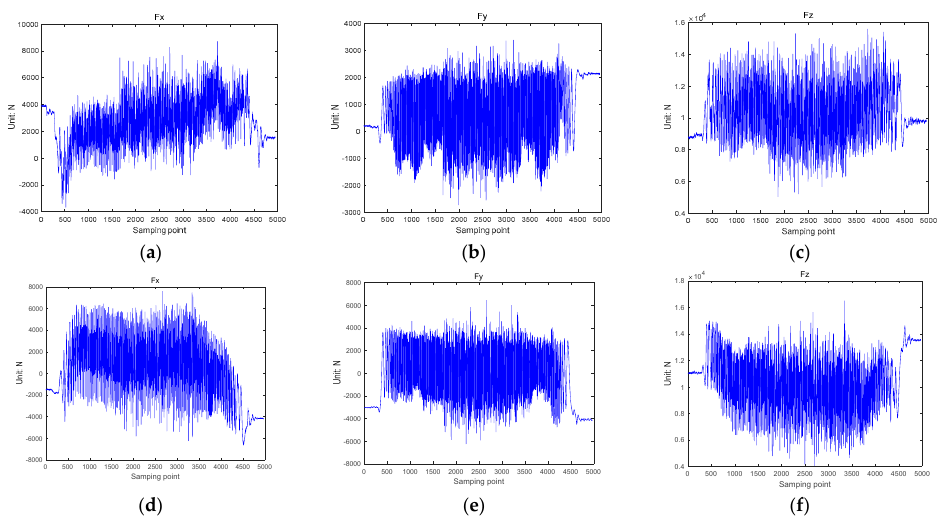
Figure 5. The original loads on the standard road, ( a ) F x of the left WFS, ( b ) F y of the left WFS, ( c ) F z of the left WFS, ( d ) F x of the right WFS, ( e ) F y of the right WFS, ( f ) F z of the right WFS. The original loads collected by the WFS on the target road are shown in Figure 6. Similar to Figure 5, Figure 6a–c represents the three ‐ dimensional loads F x , F y , and F z of the left WFS, and Figure 6d–f represents the three ‐ dimensional loads F x , F y , and F z of the right WFS. The target cobblestone road is also 200 m long. Similar to the standard road, approximately 5000 effective points are collected. From Figure 6a,d, it can be seen that the driving force F x is about 2000 N. From Figure 6b,e, it can be seen that the lateral force F y is about 0 N. From Figure 6e,f, it can be seen that the vertical force F z is about 10,000 N. Comparing Figure 5 and 6, the data of the three ‐ dimensional load have a small difference, and it is difficult to find the essential differences between the two roads. It is not easy to distinguish the difference between the original loads of standard road and the original loads of the target road from the curve form, and it is difficult to quantify the damage degree of the target road. However, if these intensities of load are quantified by suitable methods, it will easy to see the degree of wear of the target road. The suitable method used in this paper is the rain flow ‐ counting method.